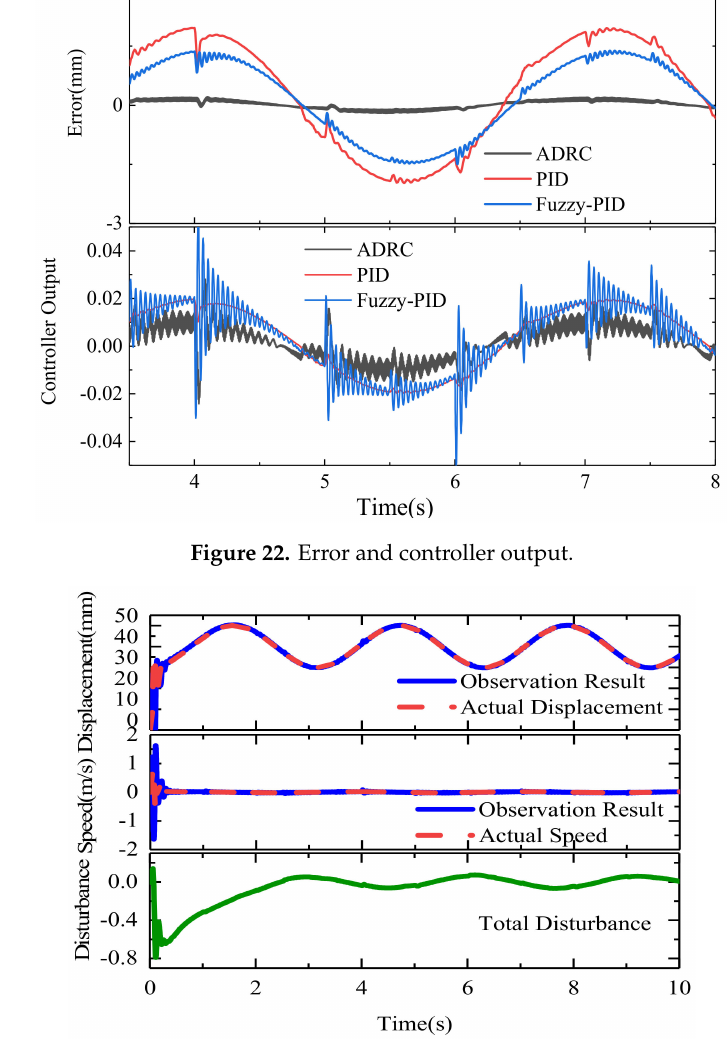
Figure 23. Observations made by extended state